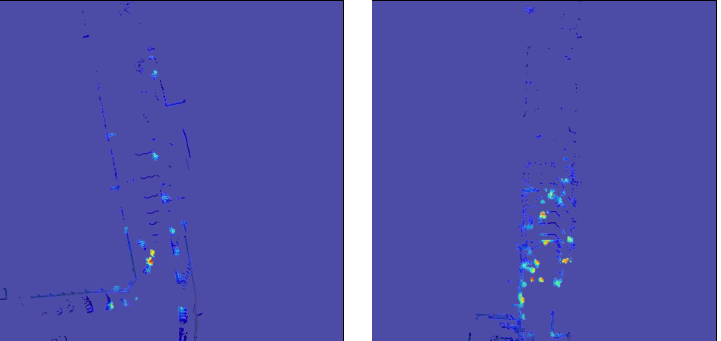
Figure 12. Comparison between results for different classes. The top left and bottom left Grad-CAMs are generated for the same scene, but for a car and bicycle class, respectively. The top right image represents a track class detection interpretation. The bottom right shows a dense urban scenario with a pedestrian detection